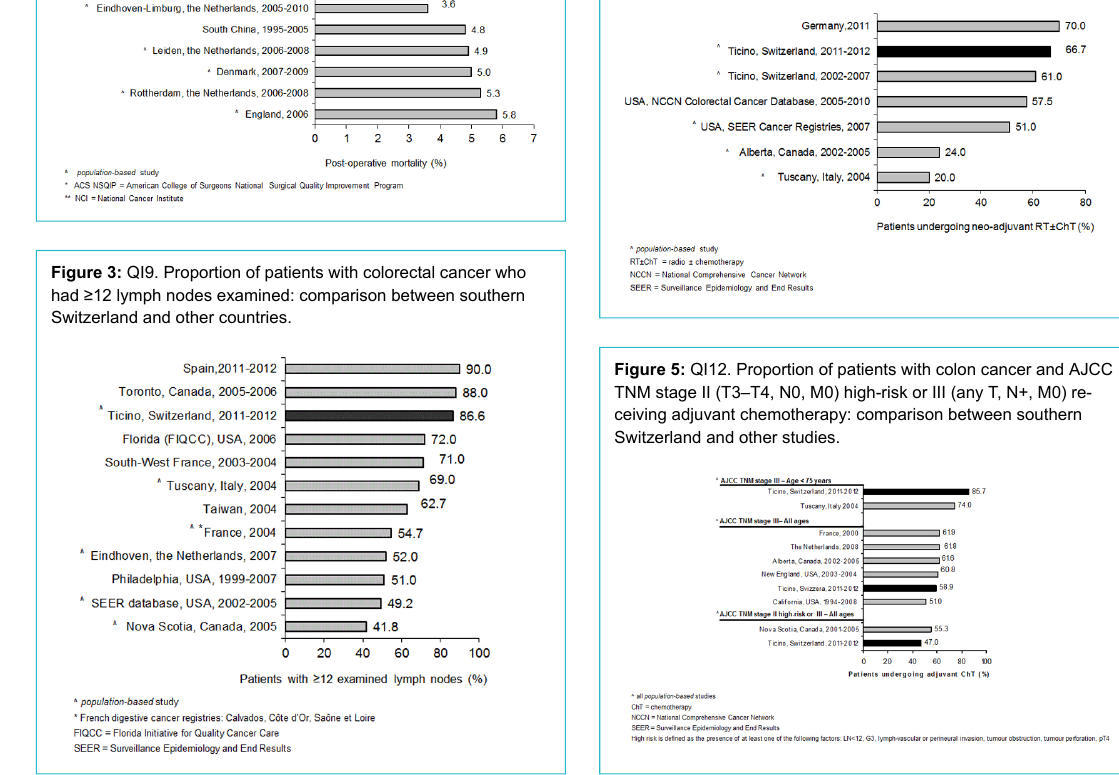
Figure 4: QI10. Proportion of patients with locally advanced rectal cancer (T3–T4 and/or any T, N+, M0) receiving neoadjuvant radio- therapy ± chemotherapy: comparison between southern Switzer- land and other studies.